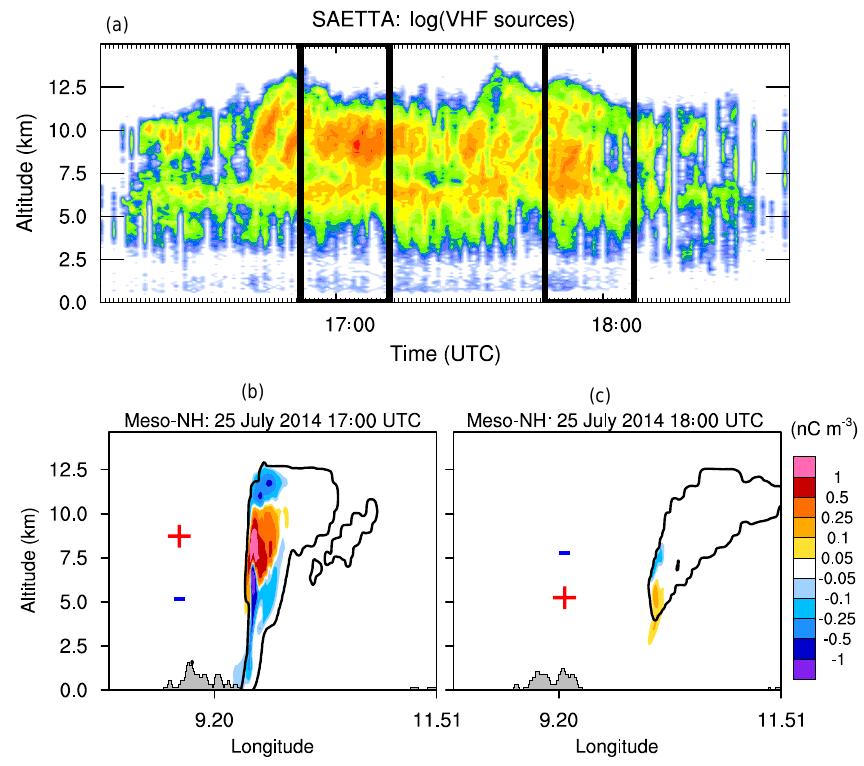
Figure 13. Comparison between the SAETTA data and the Meso-NH simulation for the case of the 25 July 2014 event over Corsica. Time series of the vertical profiles of the SAETTA VHF sources (a) and Meso-NH cross sections of the total charge density (nCm − 3 ; colors) corresponding to the windows of the SAETTA profiles with a direct cell (b) of “normal” polarity and an indirect cell (c) of “reverse” polarity. The cloudy area is shown with a black